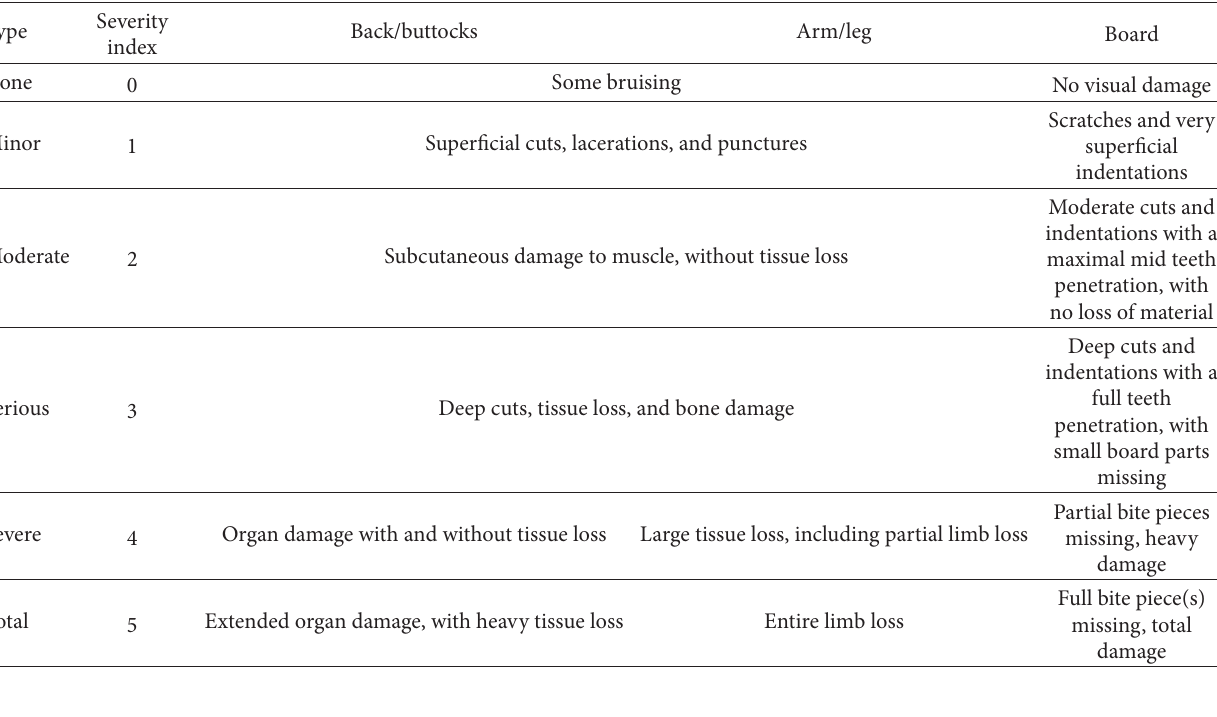
Table 2: Categorization of body areas, wound intensity, and board damage caused by white sharks during incidents with surfers. Type